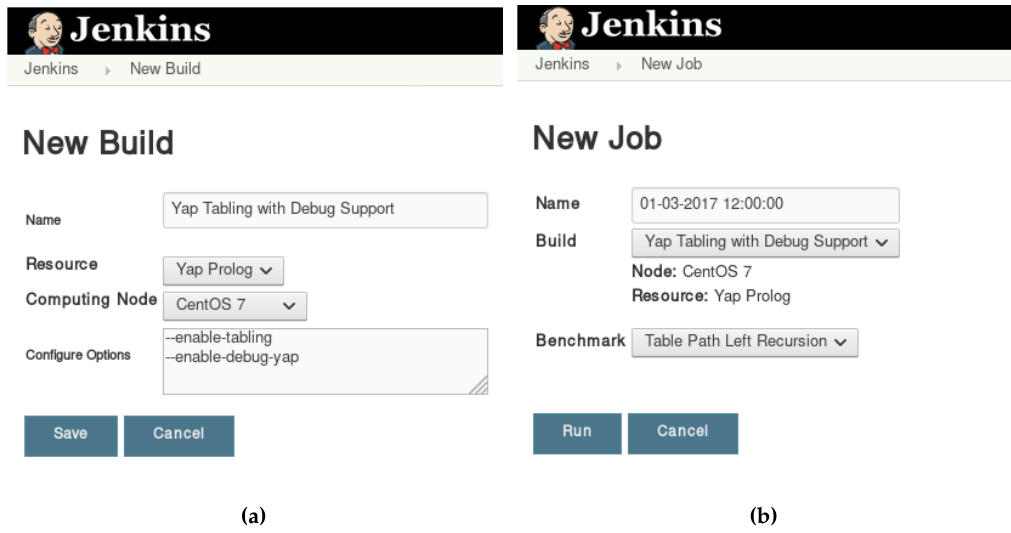
Figure 12. Job management graphical user interface (GUI) for developers. ( a ) Creating a new build for the YAP Prolog system. ( b ) Running a job with a previously defined